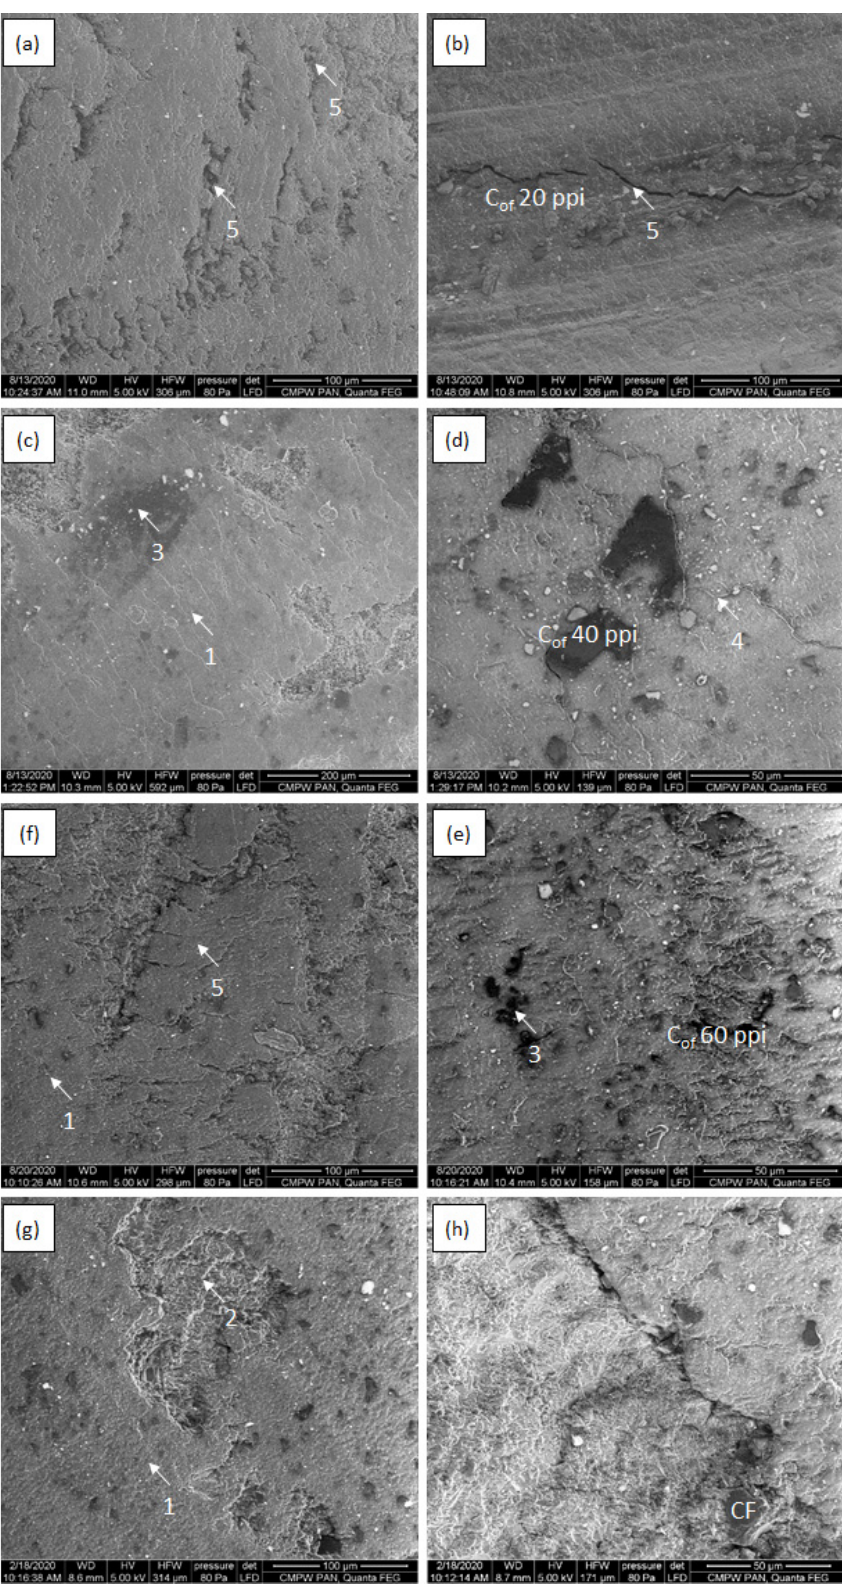
Figure 11. SEM micrographs of epoxy—C of 20 ppi ( a , b ), epoxy—C of 40 ppi ( c , d ),epoxy—C of 20 ppi ( e , f ) and epoxy–CF ( g , h ) after cooperation with cast iron counter sample under 5.0 MPa load; 1— adhesive wear, 2—abrasive wear and adhesive shear and transfer of matrix, 3—solid tribofilm, 4— cracks at interface, 5—matrix delamination.